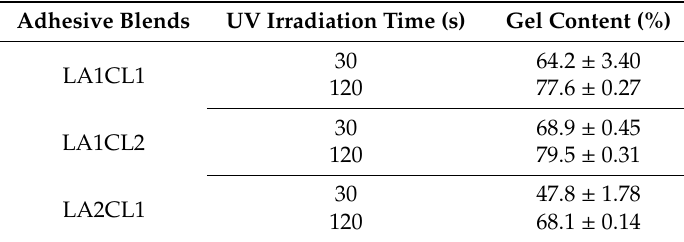
Figure 4. Dynamic water contact angles profiles obtained for the different adhesive formulations. Table 1. UV exposure times (s) and corresponding gel content for each crosslinked adhesive.